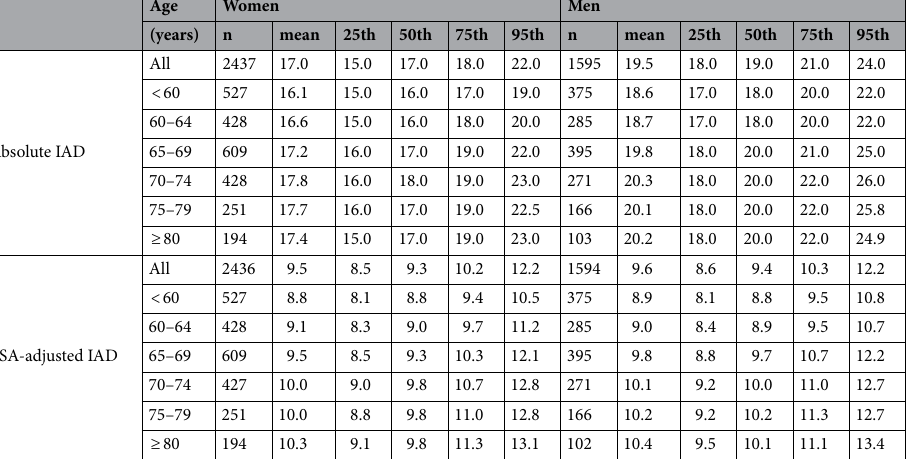
Table 2. Means and percentiles of absolute and body surface area-adjusted infrarenal aortic diameters (mm) by age among women and men. IAD infrarenal aortic diameter, BSA body surface